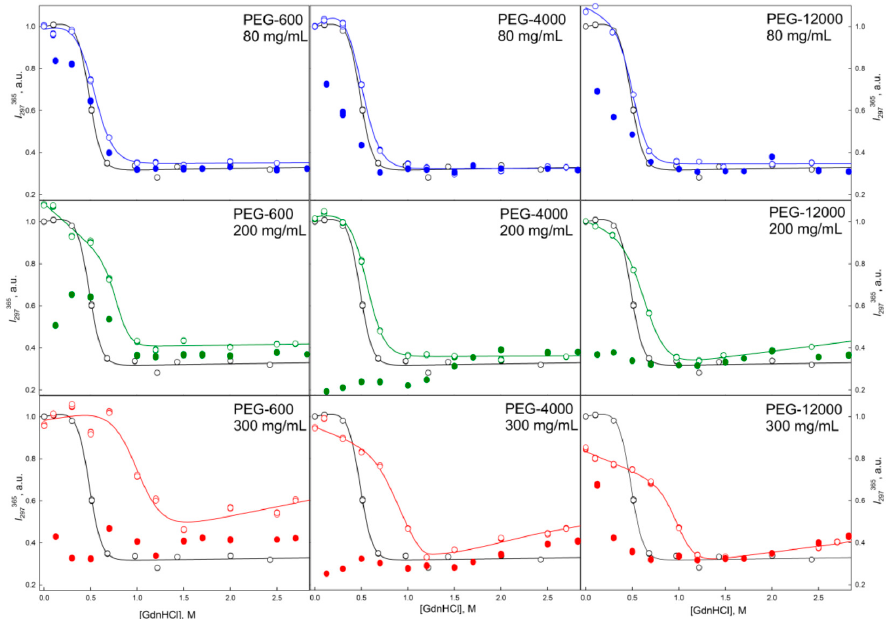
Figure 6. Unfolding/refolding transitions of GGBP in the presence of different concentrations of PEGs with different molecular weight recorded as the dependence of the intrinsic fluorescence intensity of GGBP on GdnHCl concentration. The excitation wavelength was 297 nm, the emission wavelength was 365 nm. Other designations as in Figure 4.